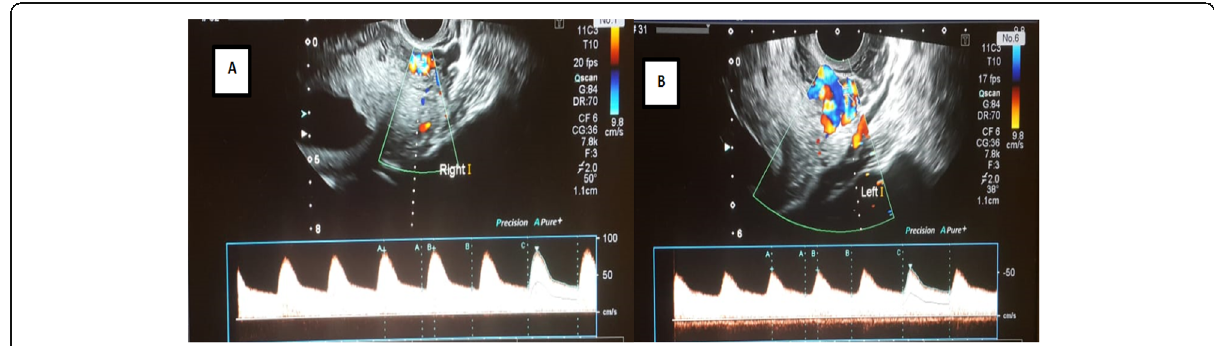
Fig. 5 a , b Transvaginal Doppler ultrasound of both uterine arteries ( a right, b left) of fertile female (control group) aged 28 years old shows RI of right and left uterine arteries were 0.61 and 0.53 respectively with mean RI 0.57, S/D ratios of right and left uterine arteries were 2.59 and 2.1 respectively with mean S/D ratio 2.34, and PI of right and left uterine arteries were 0.95 and 0.75 respectively with mean PI